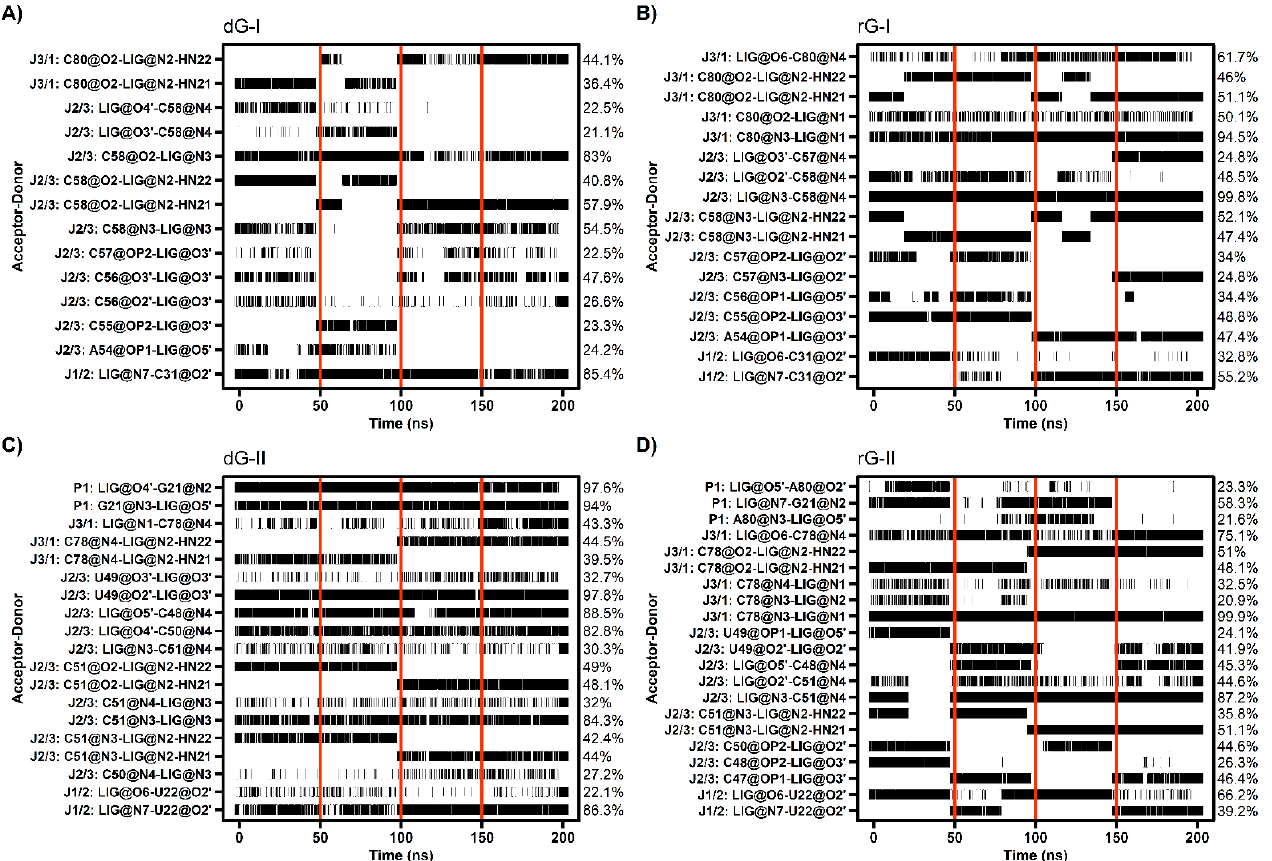
Figure 5. Hydrogen bond between 2′-dG-I ( A , B ) and 2′-dG-II ( C , D ) riboswitches with dG ( A , C ) and rG ( B , D ) ligands. The occupancy of each interaction is on the right axis. The calculation was performed for the last 50 ns of each replicate, which was separated by red vertical lines.